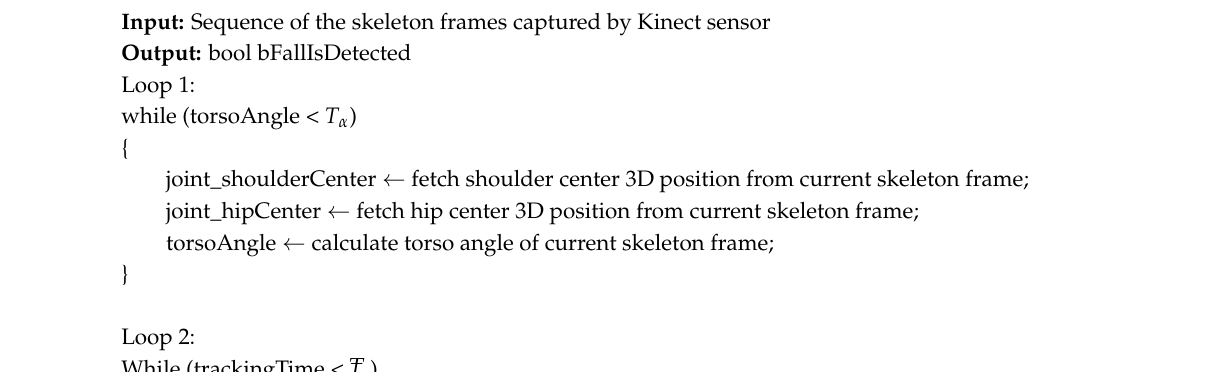
Algorithm 1: Pseudocode of our proposed method for fall detection.